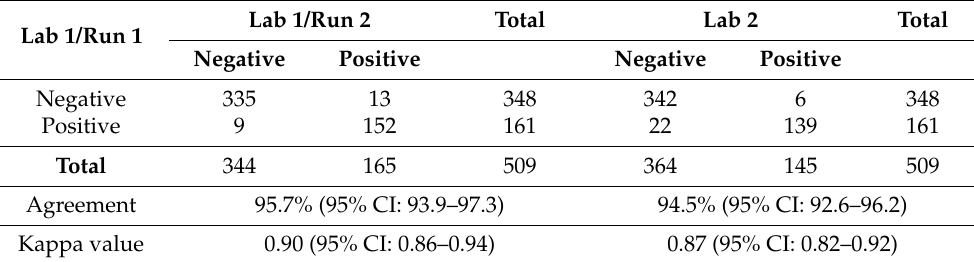
Table 2. Intra-laboratory reproducibility and inter-laboratory agreement analyses of the NeuMoDx HPV assay on cervical specimens.